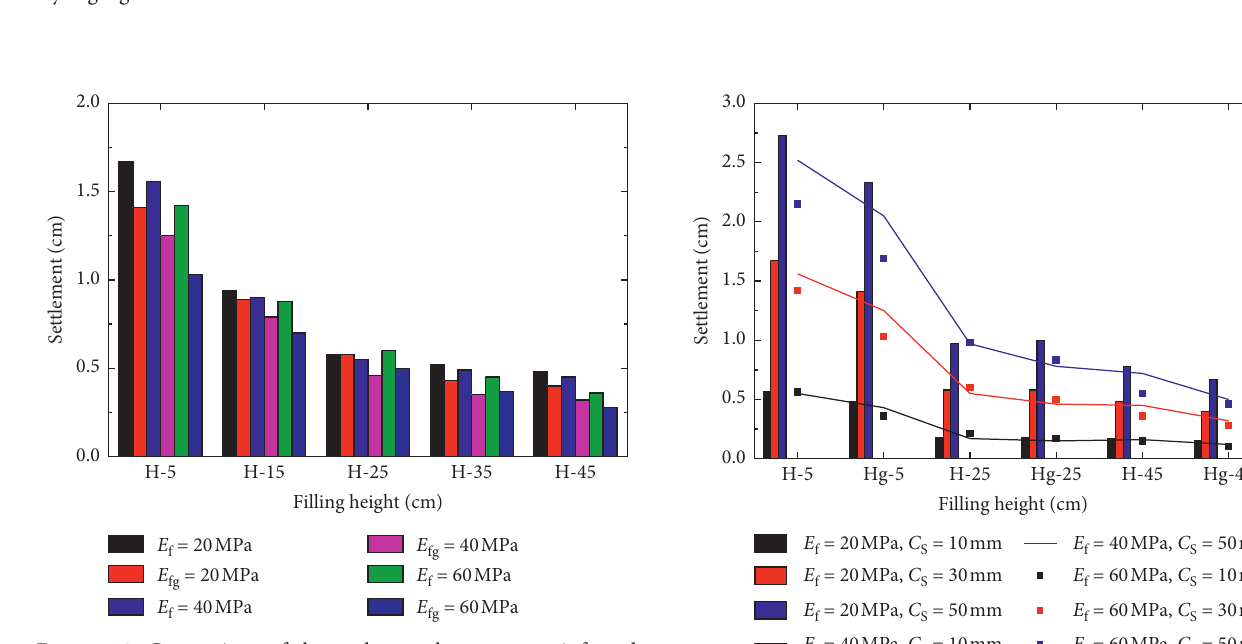
Figure 17: Variation of the settlement with filling height under different filling modulus conditions. (a) Unreinforced condition. (b) One- layer geogrid-reinforced condition.